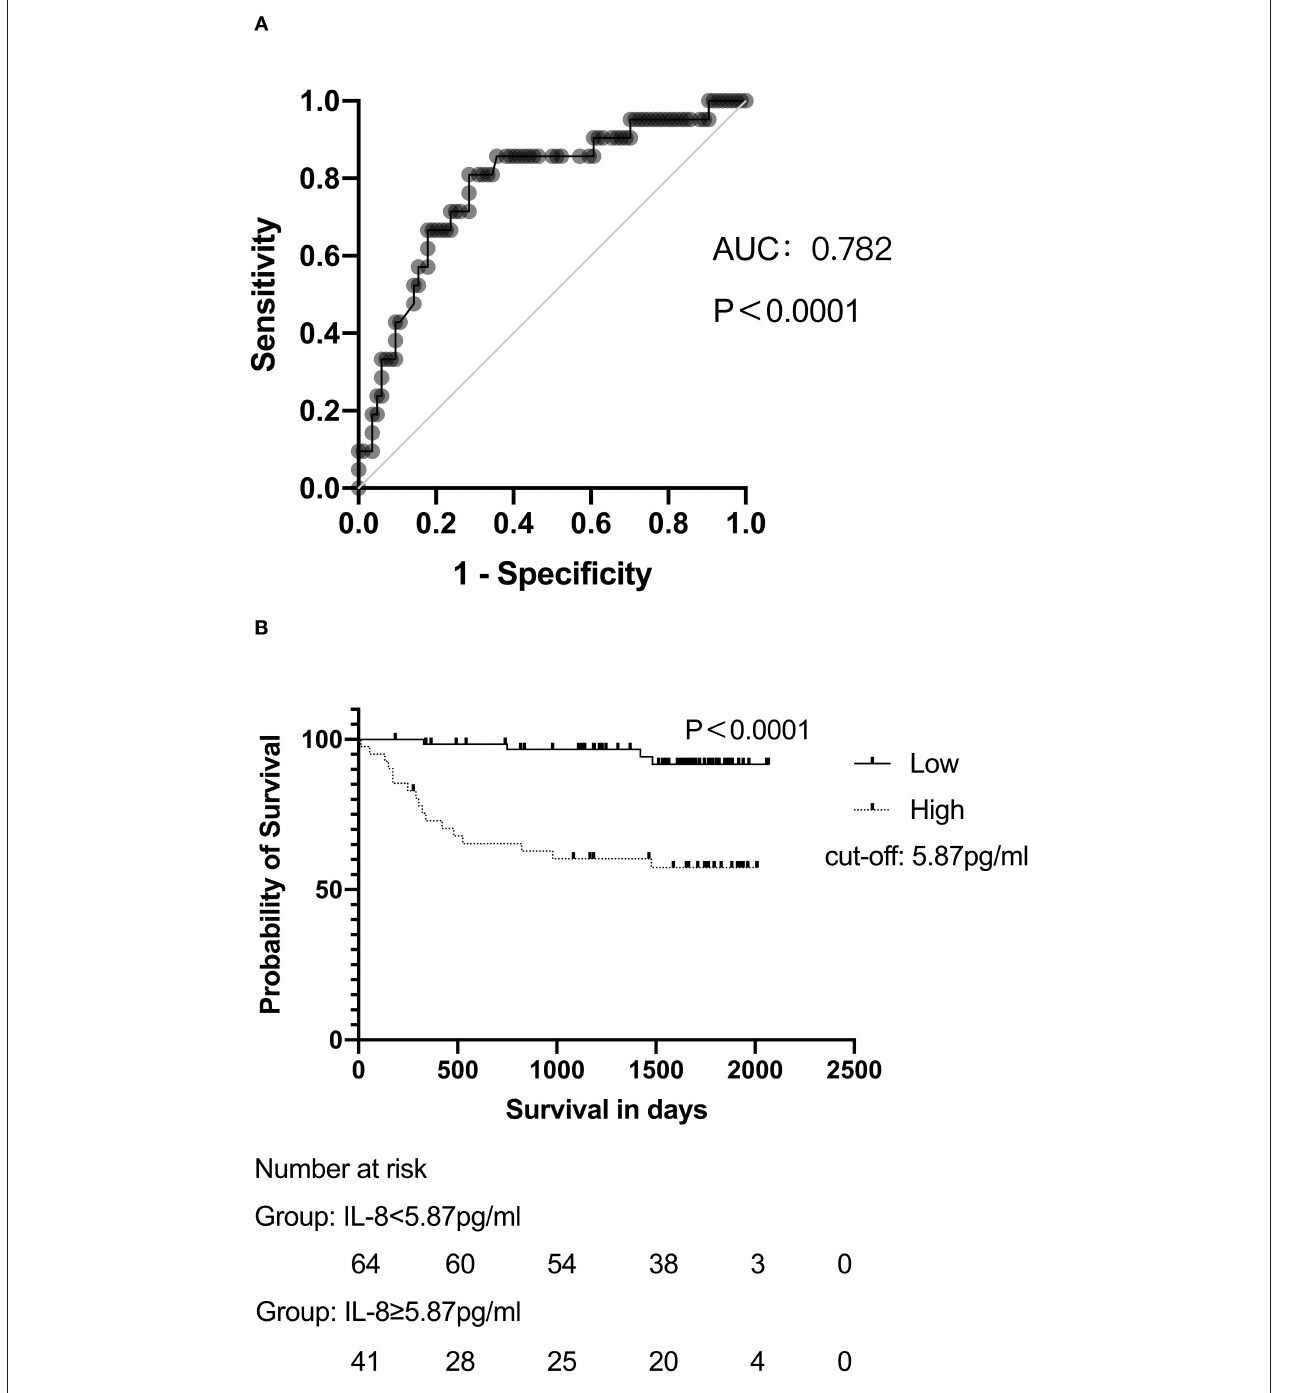
FIGURE 3 | IL-8 levels are associated with the survival of patients with cirrhosis undergoing the TIPS procedure. (A) ROC analyses demonstrated the predictive value of hepatic IL-8 levels before the TIPS procedure. (B) Patients with hepatic IL-8 levels > 5.87 pg/mL presented lower survival rates than patients with lower hepatic IL-8 levels after long-term follow up. In (B) , data were analyzed with the log-rank test and depicted as Kaplan–Meier curves. our cohort. Previous studies illustrated that lipid accumulation to the level of lipid accumulation in the liver in patients in hepatocytes induced the production of IL-8, which was a with non-viral cirrhosis. In patients with non-viral cirrhosis, significant discriminator of non-alcoholic steatohepatitis most had non-alcoholic steatohepatitis or alcohol hepatitis in